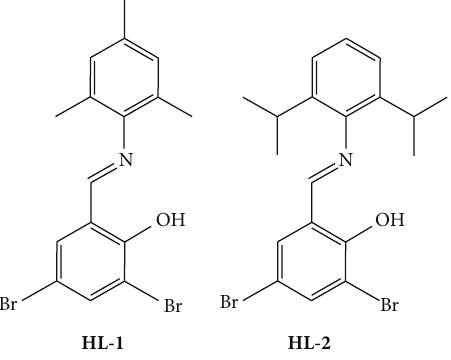
Scheme 1: The molecular structures of HL1 and HL2